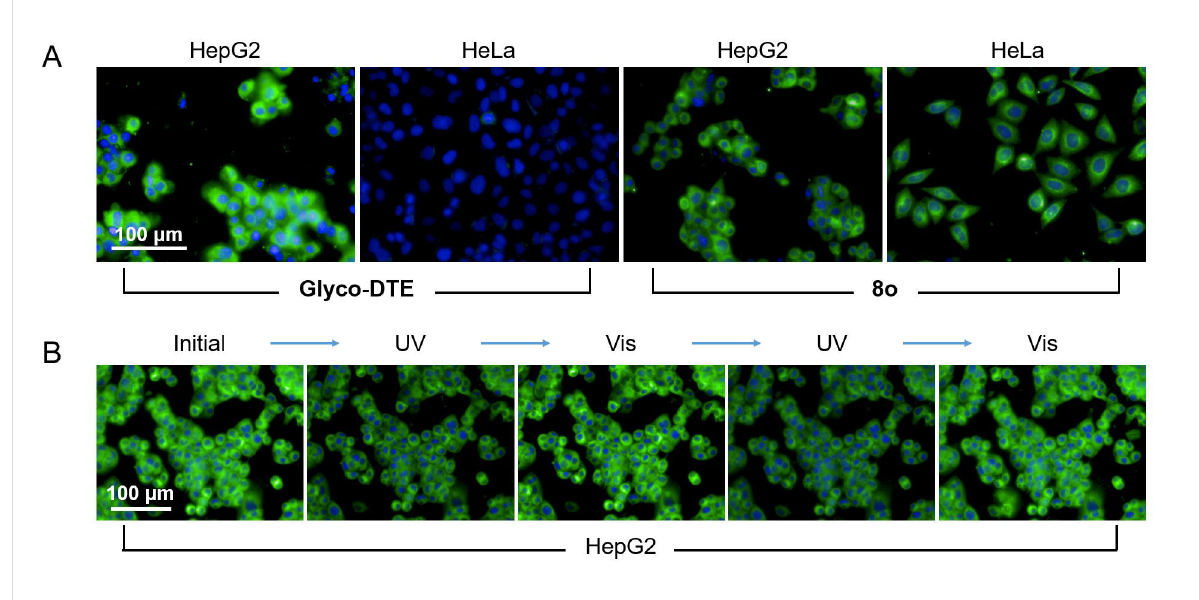
Figure 4: (A) Fluorescence imaging of HepG2 cells and HeLa cells after incubated with reporters Glyco-DTE (20 μ M) and 8o (20 μ M) for 30 min. (B) The photochromic fluorescence imaging of HepG2 cells after incubated with reporter Glyco-DTE (20 μ M) upon alternating irradiation with UV (254 nm) and visible light (>500 nm). The excitation wavelength is 440 nm and the emission channel is 450–550 nm.